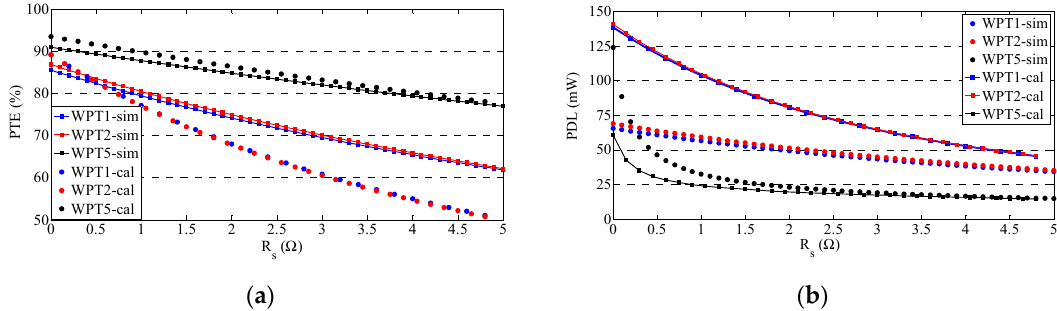
Figure 4. E ff ect of source resistance on the power transfer e ffi ciency ( a ) and power delivered to the load ( b ). The terms “-cal” and “-sim” refer to the calculation and simulation results,